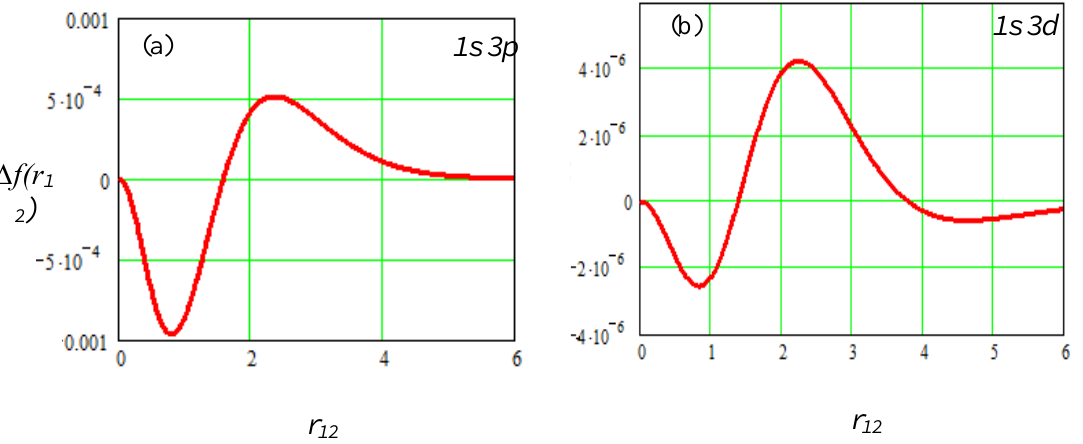
Fig. 4: The Fermi hole ∆ f(r